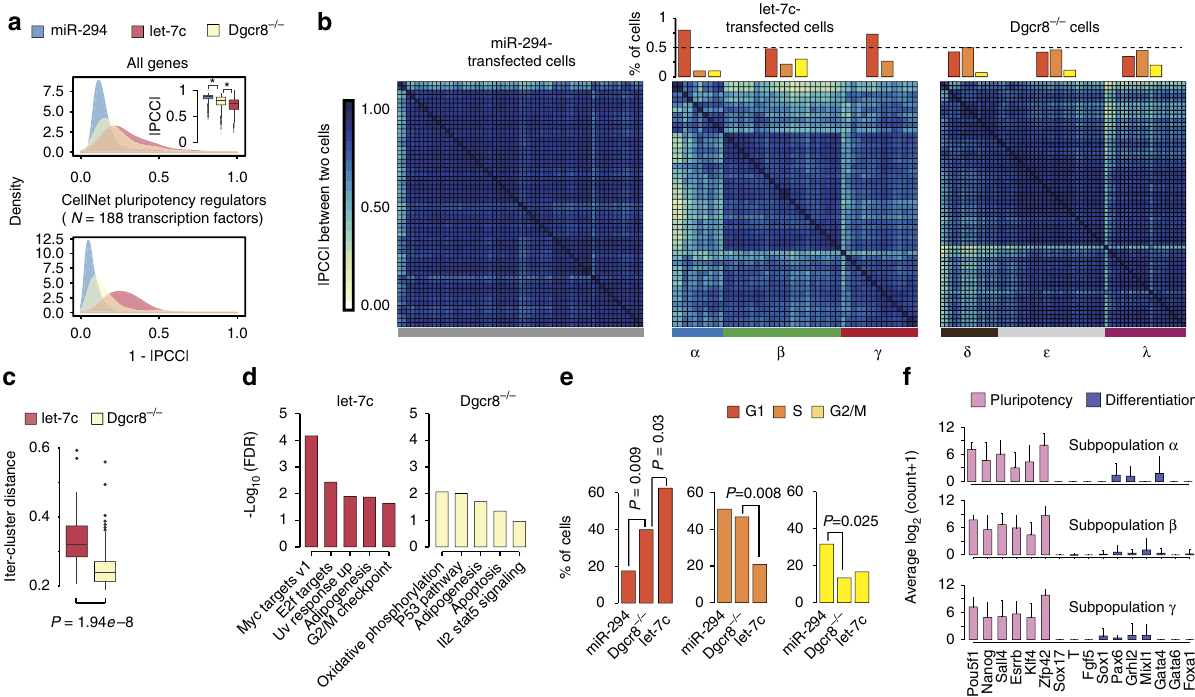
Figure 3 | Cell-cell correlations within Dgcr8 (cid:2) / (cid:2) and Dgcr8 (cid:2) / (cid:2) transfected with either miR294 or let-7c. ( a ) Density plots of distances (|1–|PCC|) between pairs of cells within each condition. Top plot is for all genes, whereas bottom plots is for CellNet pluripotency regulators as defined in ref. 14. Top plot inset shows PCC distribution between pairs of cells within each condition. It is worth noting that miR-294 increases homogeneity when considering all genes or pluripotency genes. ( b ) Heatmaps showing all within condition cell–cell PCC using all genes. Cells are ordered by hierarchical clustering and subpopulation of cells identified with Dynamic tree cut method (see Methods). Above each heatmaps the percentage of cells in each of the cell cycle phases is reported for each identified sub-population of cells as defined by Cyclone. ( c ) Inter-cluster distance distribution between clusters (that is, subpopulations) of cells shown in b . Inter-cluster distance for a cell x was defined as its average distance from all the other cells, expect the ones in the same subpopulation as cell x . Let-7c inter-cluster distance is significantly higher than Dgcr8 (cid:2) / (cid:2) inter-cluster distance (two tailed Wilcoxon test P ¼ 1.94 e (cid:2) 8), meaning that let-7c is producing more distinct and better separated sub-populations of cell compared to the ones identified in Dgcr8 (cid:2) / (cid:2) cells. ( d ) Identification of pathways driving the formation of subpopultions of cells within let-7c or Dgcr8 knockdown conditions. Pathways are sorted according the corrected P -value (that is, FDR) returned by the ANOVA. Only top five significant pathways are shown. ( e ) Percentage of cells in each of the cell cycle phases for miRNA-transfected and Dgcr8 (cid:2) / (cid:2) -deficient cells. Exact Fisher’s test is used to the compare number of cells in each cell cycle stage between miRNA-transfected versus Dgcr8-knockdown cells. ( f ) Average expression of six pluripotency and ten differentiation markers across the three identified subpopulations of let-7c-transfected